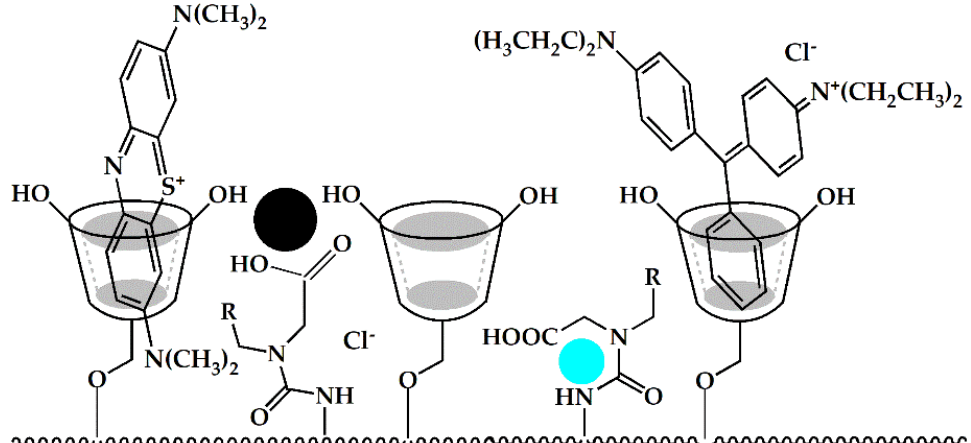
Figure 3. Fragment of the structure of the cyclodextrin adsorbent interacting with dyes and metal cations.